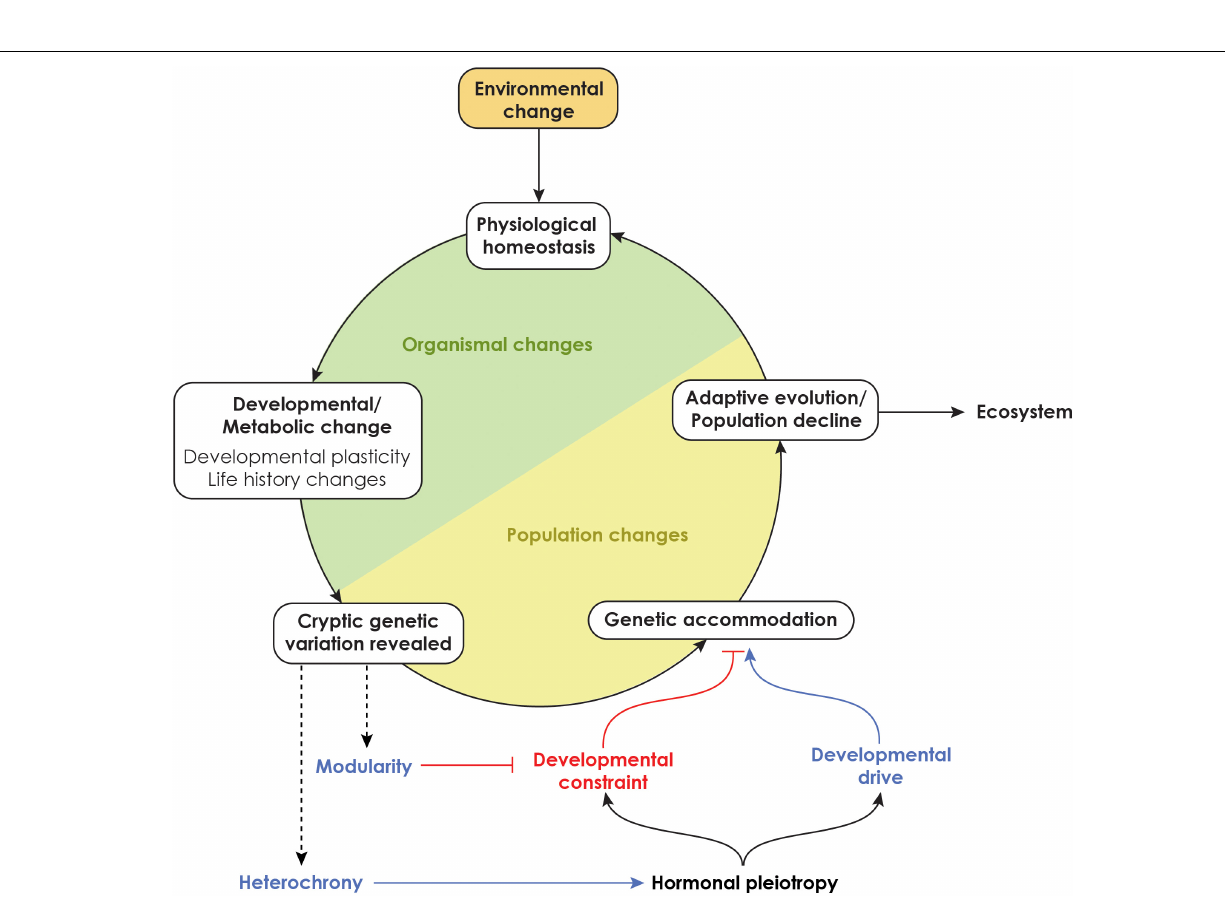
Frontiers in Ecology and Evolution |